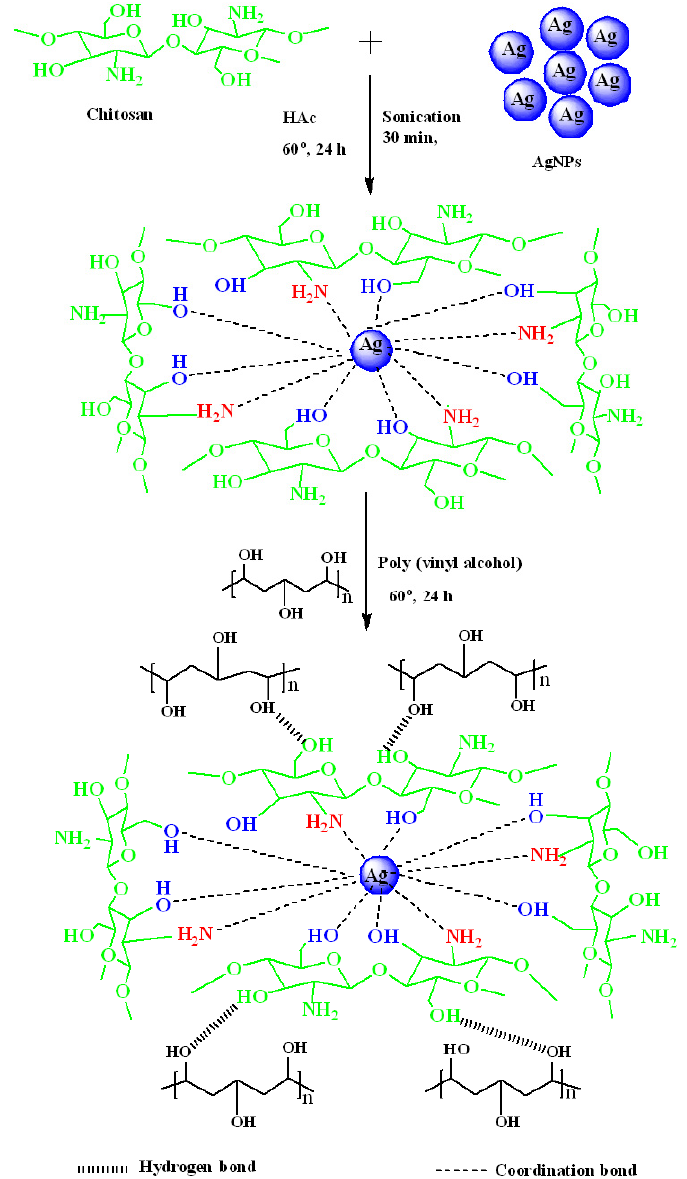
Figure 10. Scheme for the fabrication of CS-capped AgNP-incorporated PVA hybrid membranes .